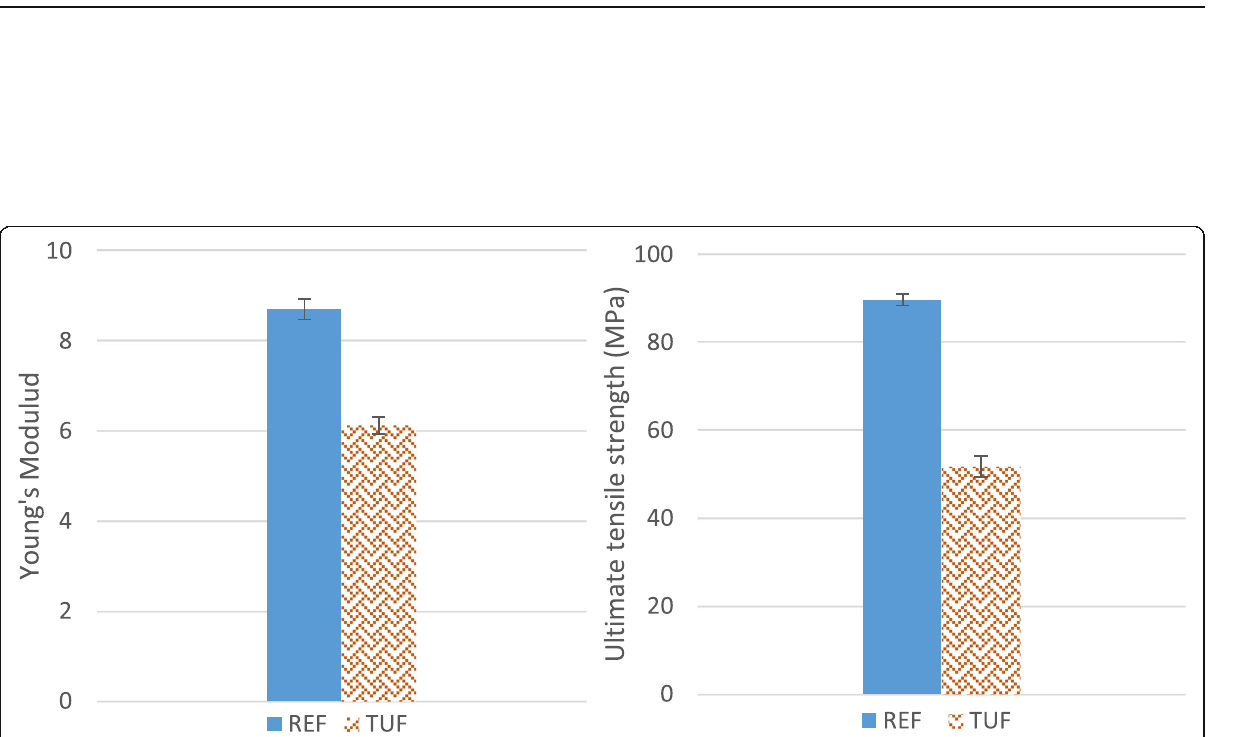
Fig. 15 Percentage decrease in the young ’ modulus and ultimate tensile strength of Tufted green